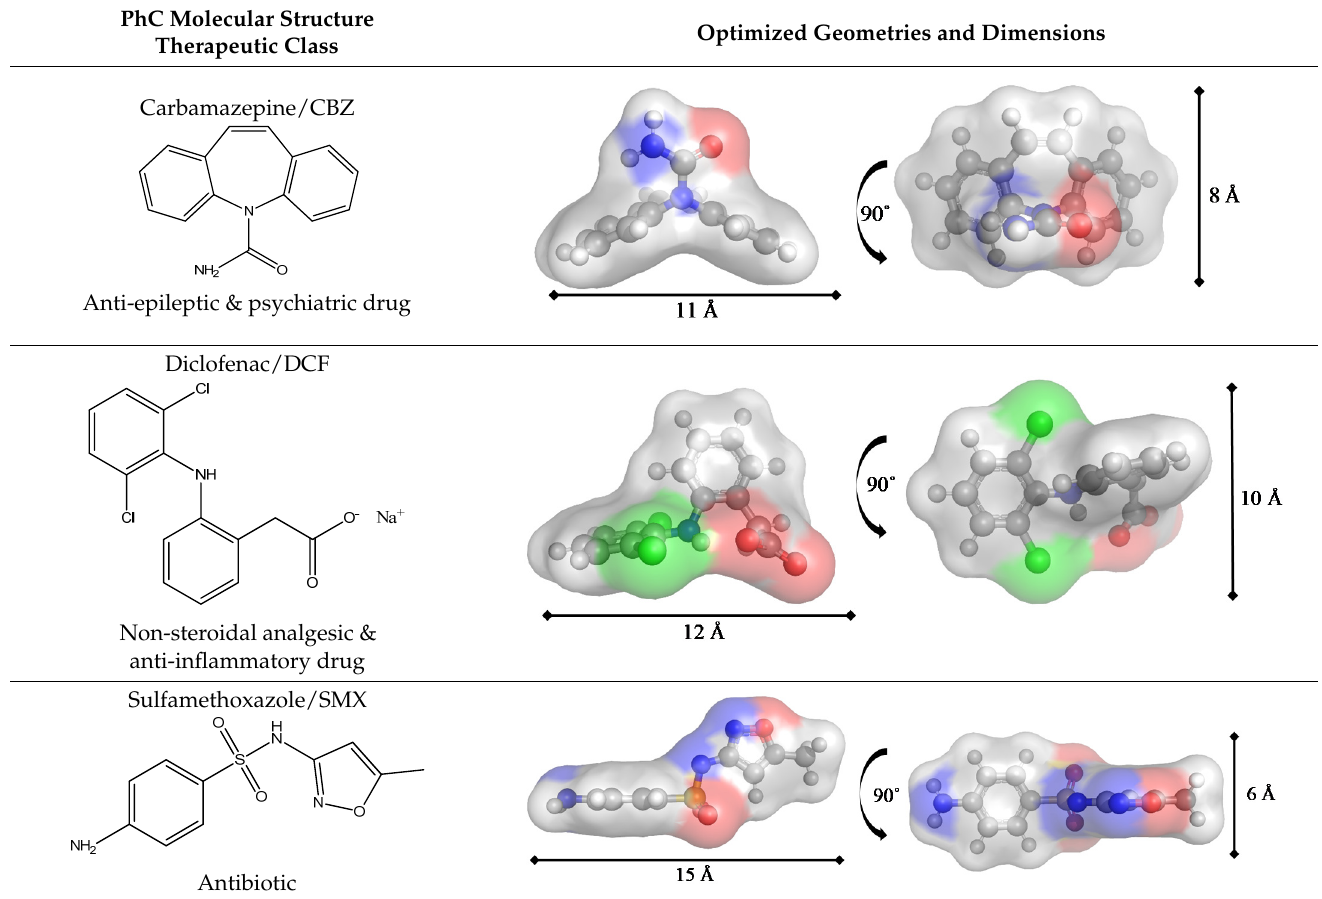
Table 1. Molecular structures, therapeutic classes and optimized geometries of the extended con- formation of carbamazepine/CBZ, diclofenac/DCF anion and sulfamethoxazole/SMX anion.